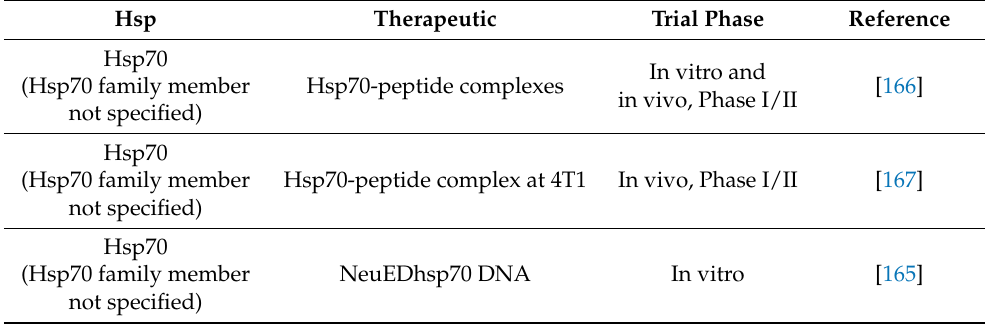
Table 2. Hsps-based vaccines against breast cancer in clinical